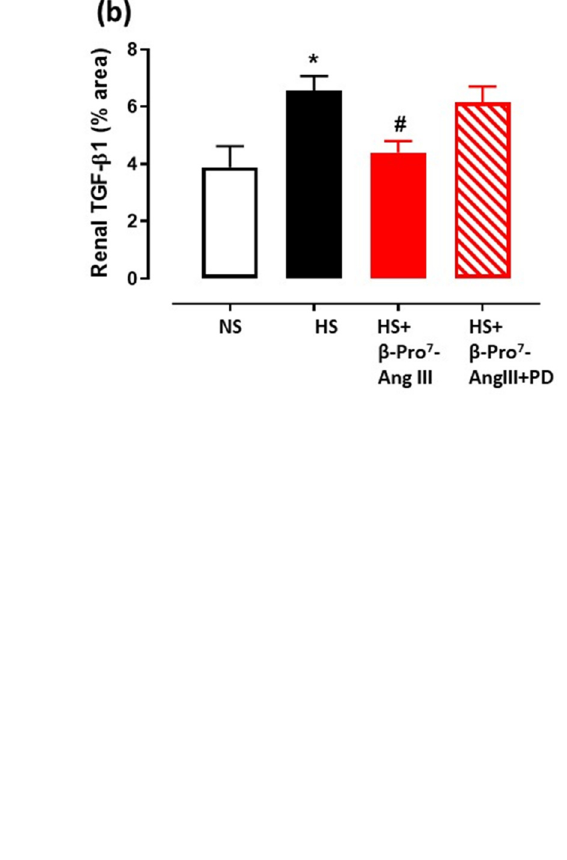
Figure 4. ( a ) Representative images for TGF- β 1 in kidney sections obtained from FVB/N male mice fed on a normal salt (NS, 0.5% NaCl) diet or mice fed on a high salt (HS, 5% NaCl) diet in the presence or absence of β -Pro 7 -AngIII (0.1 mg/kg/day) +/ − PD123319 (1 mg/kg/day). Scale bar for all images = 50 μ m. ( b ) Group data of % area of TGF- β 1 in cardiac sections. ( c ) Plasma TGF- β 1 levels (n = 7–8 per group). All data are expressed as mean ± s.e.m. * p < 0.05 vs. sham; # p < 0.05 vs. HS, determined by One-Way ANOVA with Tukey correction for multiple comparisons.